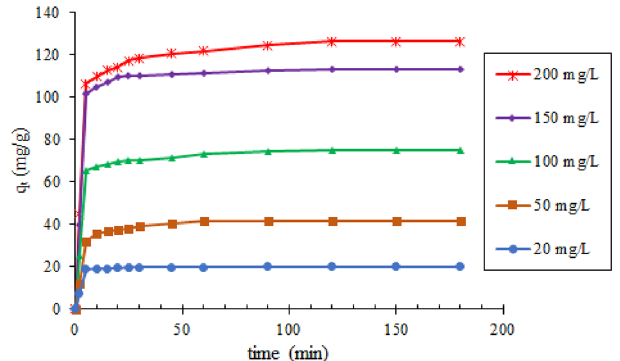
Figure 10. Effect of contact time and initial PNP concentration on the adsorption of PNP by TMA-(PA6- g - GMA) (0.1 g adsorbent dose, pH 5, 298 K, and 150 rpm agitation speed).